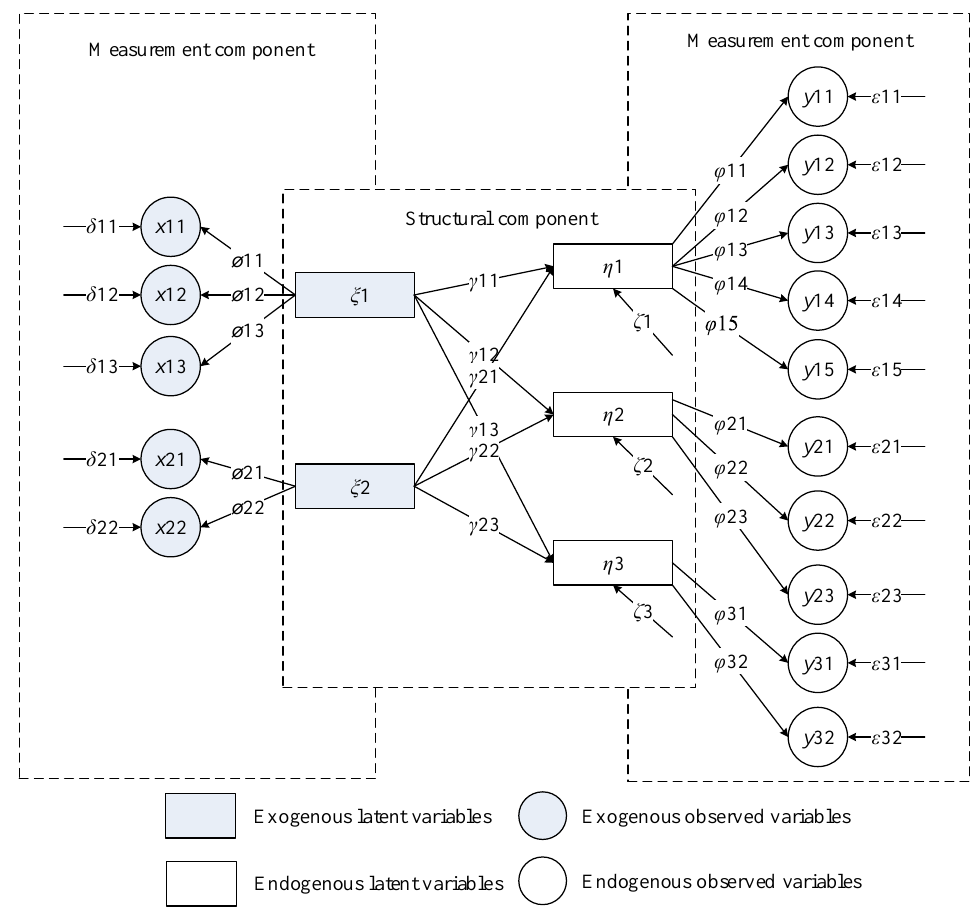
Figure 4. The concept map of the SEM.